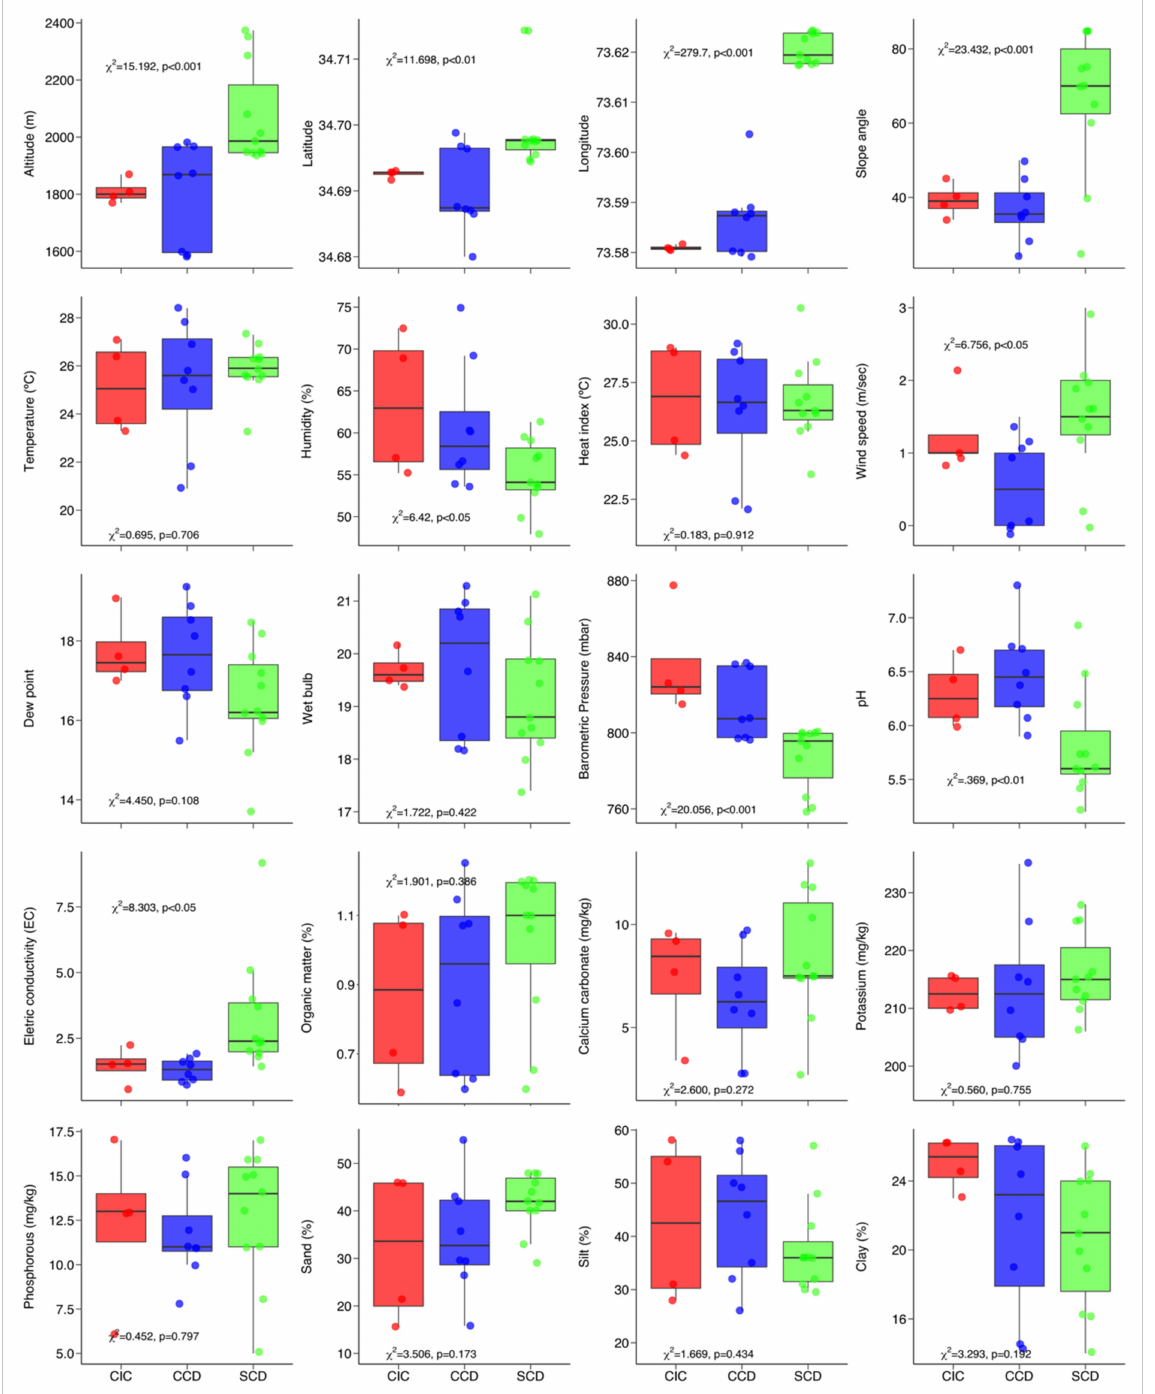
Figure 6. Variation in geographic and environmental gradients among the three plant communities of pure Deodar forests. For the complete names of plant communities, see Figure